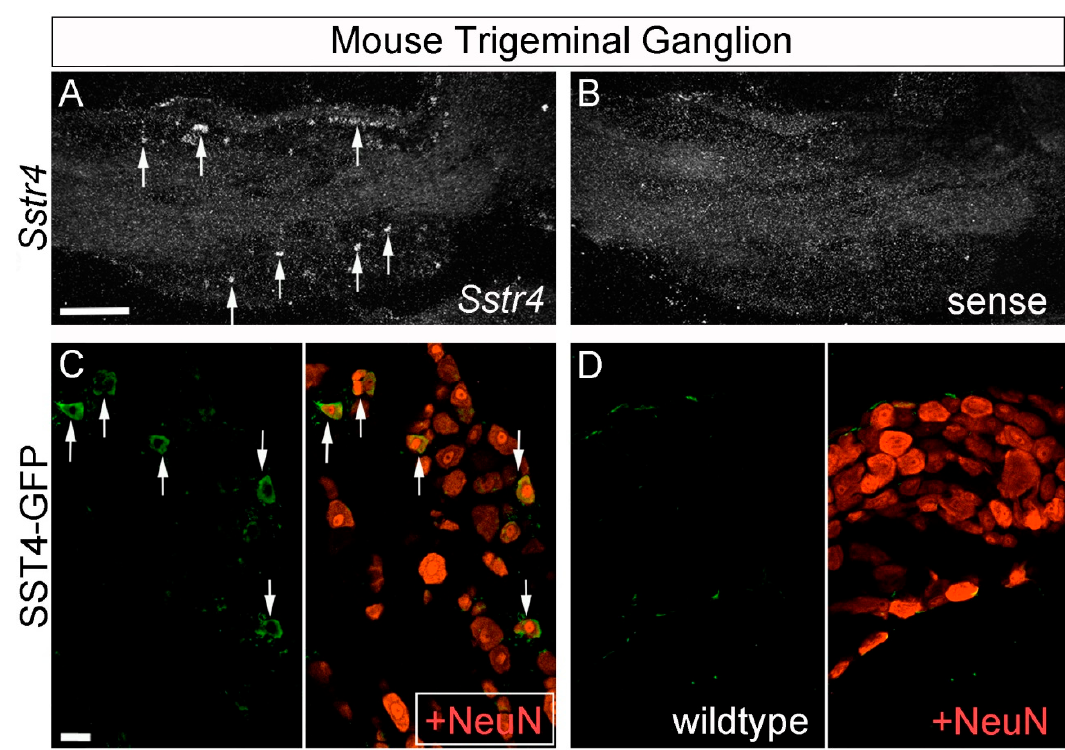
Figure 2. Sstr4 expression in the mouse trigeminal ganglion. ( A , B ) Darkfield micrographs show emulsion-dipped sections of the trigeminal ganglion after in situ hybridization with 35 S-labeled Sstr4 antisense ( A ) and Sstr4 sense riboprobes ( B ). Arrows in A identify Sstr4 -positive neurons. ( C , D ) Confocal images show double immunofluorescence stainings with antibodies for eGFP ( green ) and NeuN ( red ) in trigeminal ganglia of SST4-eGFP knockin ( C ) and wild-type mice ( D ). Arrows in ( C ) identify SST4-eGFP-positive NeuN-positive neurons. Scale bars: ( A ) 500 µm; ( C ) 25 µm.